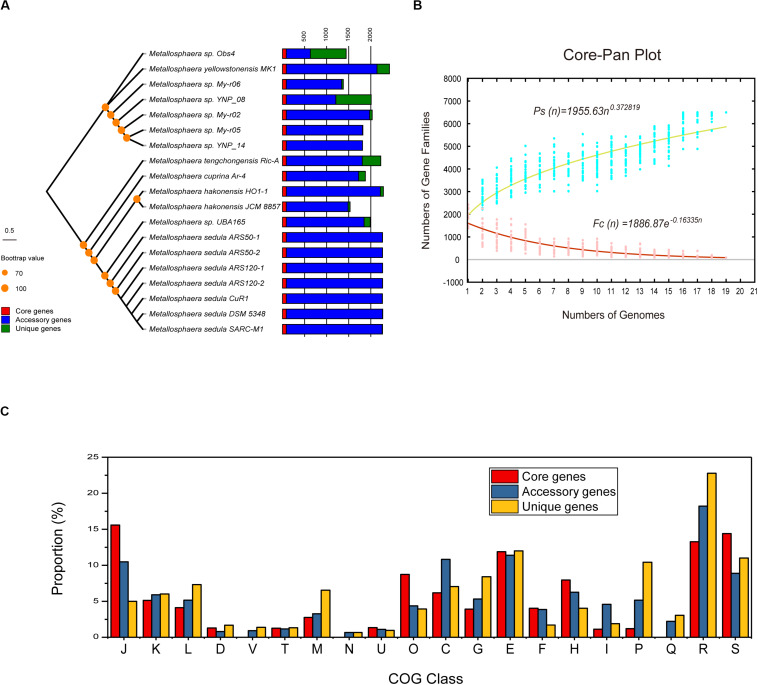
Pan-genome analyses of strains in the genus Metallosphaera. (A) NJ phylogenetic tree based on concatenated 85 core genes (1000 bootstrap replicates) of 19 Metallosphaera strains (left) and stack bar diagram showing sizes of orthologous genes shared by all strains (i.e., the core-genome), number of orthologous genes shared by partial strains (i.e., the accessory genome), and number of strain-specific gene families (i.e., the unique gene) in each strain. (B) The curve of the fitting function and the estimation of pan-genome and core-genome sizes of Metallosphaera. Ps and Fc stand for the total number of gene families and the number of core gene families, respectively. More details for modeling approaches are presented in Section 2.6 “Comparative Genomic Analyses of Metallosphaera”. (C) Bar chart showing proportions of COG categories of the different parts of Metallosphaera pan-genome (i.e., core, accessory, unique). COG categories description (J, translation, ribosomal structure and biogenesis; K, transcription; L, replication, recombination and repair; D, cell cycle control, cell division, chromosome partitioning; T, signal transduction mechanisms; M, cell wall/membrane/envelope biogenesis; N, Cell motility; U, intracellular trafficking, secretion, and vesicular transport; O, posttranslational modification, protein turnover, chaperones; C, energy production and conversion; G, carbohydrate transport and metabolism; E, amino acid transport and metabolism; F, nucleotide transport and metabolism; H, coenzyme transport and metabolism; I, lipid transport and metabolism; P, inorganic ion transport and metabolism; Q, secondary metabolites biosynthesis, transport and catabolism; R, general function prediction only; S, function unknown).